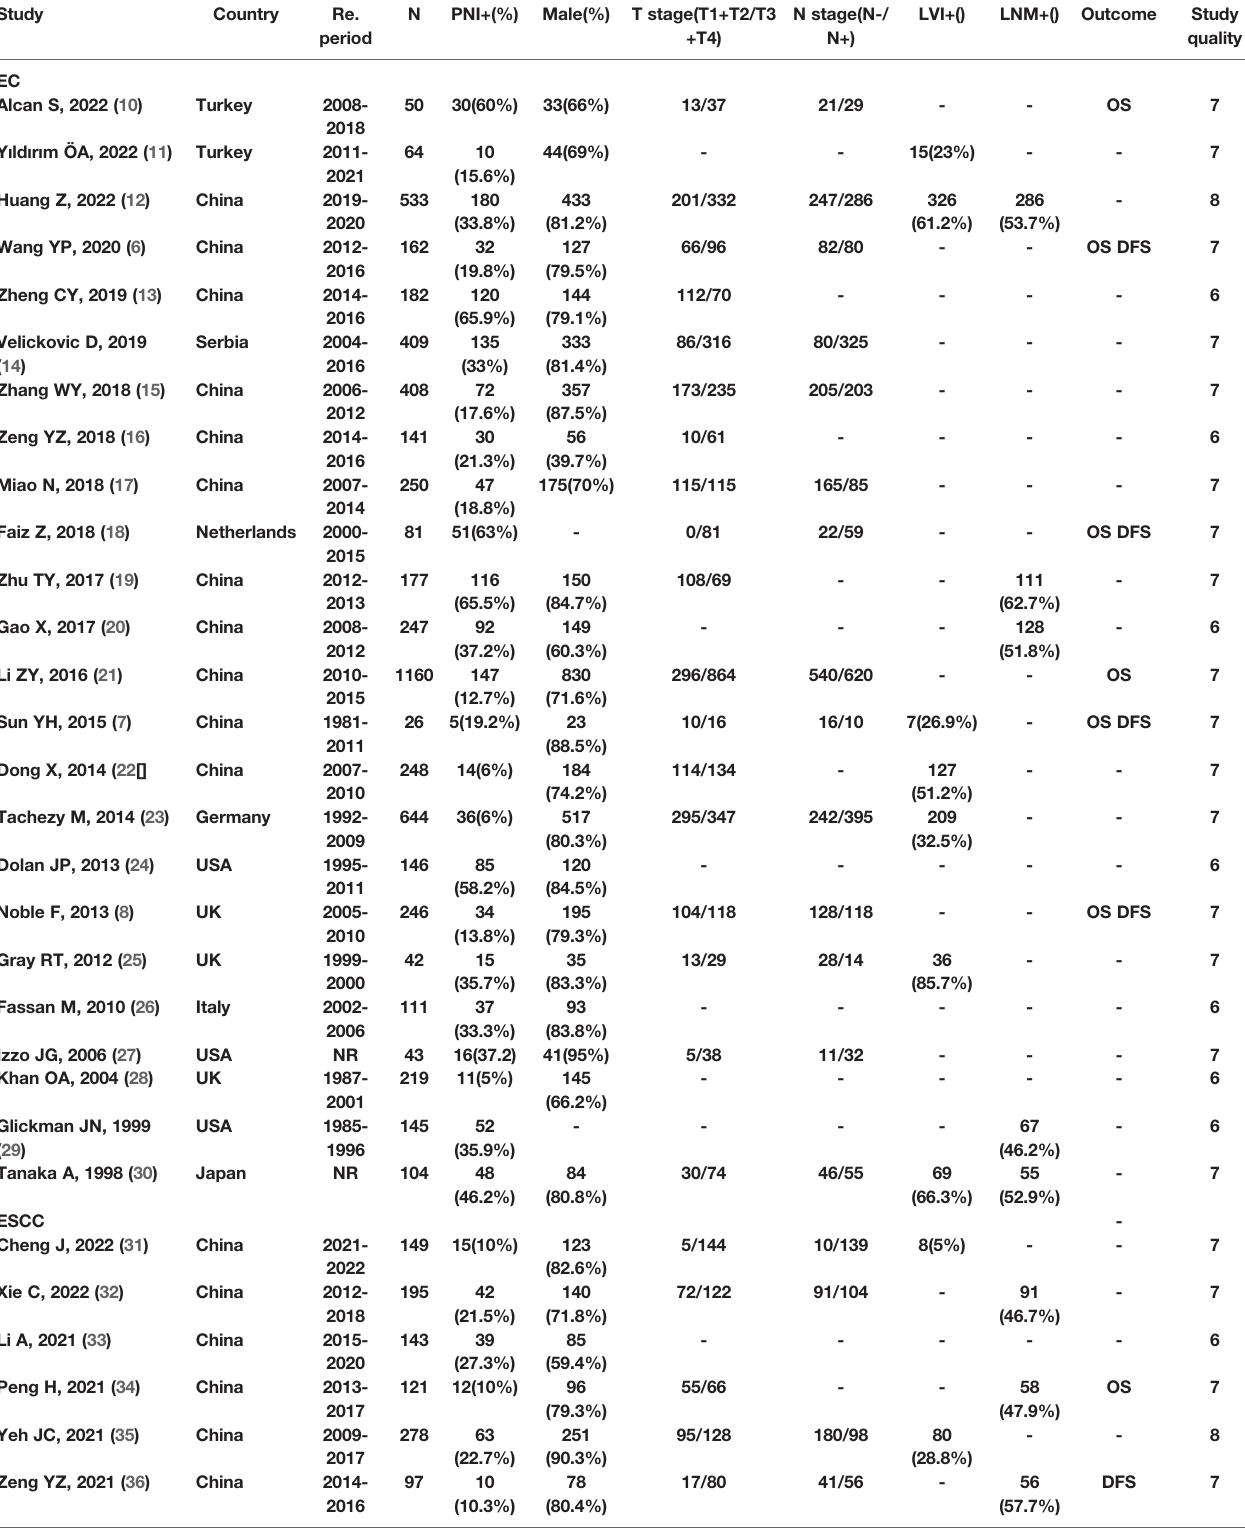
TABLE 1 | The distribution of PNI in different pathological types of esophageal cancer.